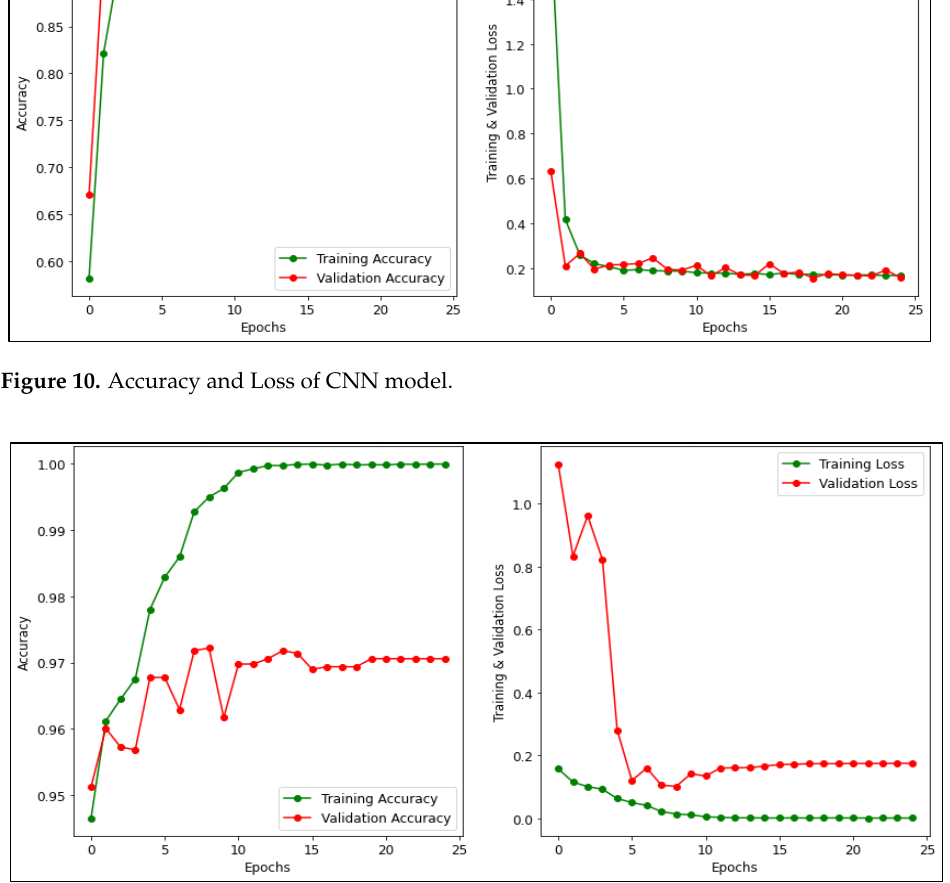
Figure 11. Accuracy and Loss of MobileNetV2 model.